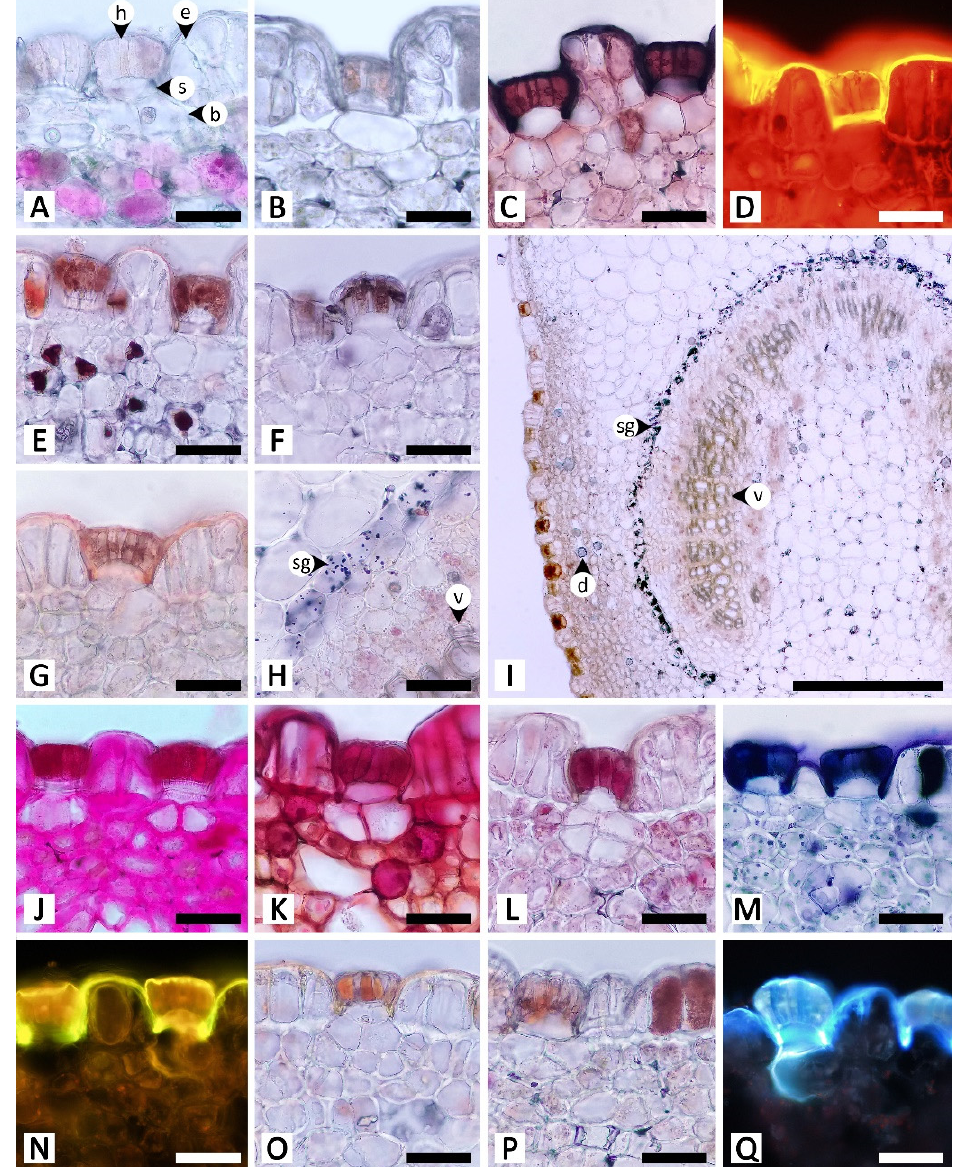
Figure 6. Histochemical results obtained from petiolar nectaries of Rivea ornata . ( A ) Unstained petiolar nectary from the Mae Hong Son study site showing anthocyanins in the nectariferous parenchyma. ( B ) Unstained petiolar nectary from the Sakon Nakhon study site without anthocyanins in the nectariferous parenchyma. ( C ) Sudan black B test for total lipids. ( D ) Neutral red fluorochrome test for total lipids. ( E ) Ferric chloride test for phenolic compounds. ( F ) Potassium dichromate test for phenolic compounds. ( G – I ) Lugol’s iodine test for starch; note that positive results are only present in a strand of parenchyma cells surrounding the vascular bundle. ( J ) Periodic acid–Schiff’s reagent (PAS) test for neutral polysaccharides. ( K ) Ruthenium red test for acidic polysaccharides. ( L ) Mercuric bromophenol blue test for proteins. ( M ) Nadi reagent test for terpenoids. ( N ) Naturstoff reagent A under fluorescent microscopy detecting flavonoids. ( O ) Dragendorff reagent test for alkaloids. ( P ) Wagner’s reagent test for alkaloids. ( Q ) UV autofluorescence of petiolar nectaries. Note: ( C – F , H – K , M – P ) show positive reactions, while ( G , L ) show negative reactions. Abbreviations: b, base; d, druse crystal; e, epidermal cell; h, head; s, stalk; sg, starch grain; v, vascular tissue. Scale bars: ( A – H , J – Q ) 50 μ m; ( I ) 500 μ m.